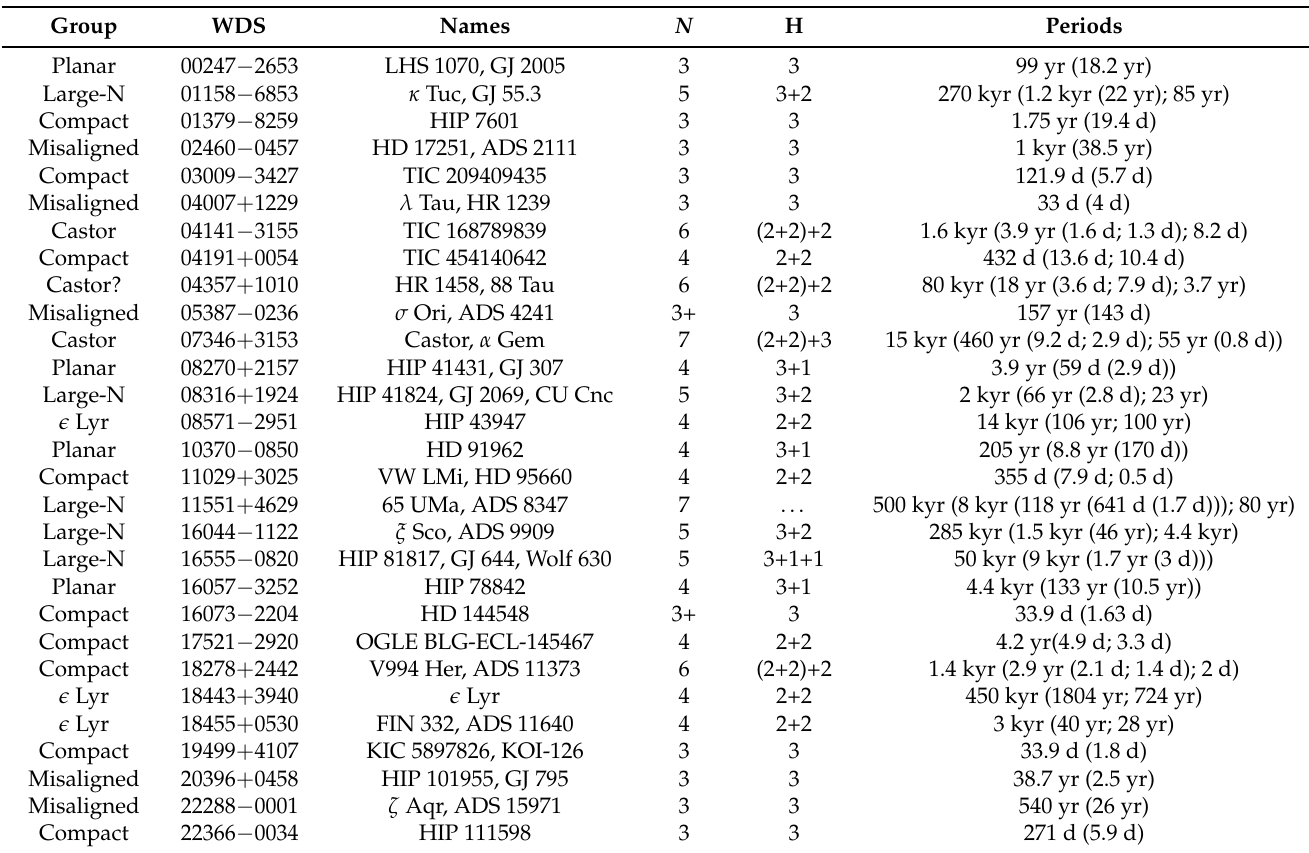
Table 2. Selected Multiple